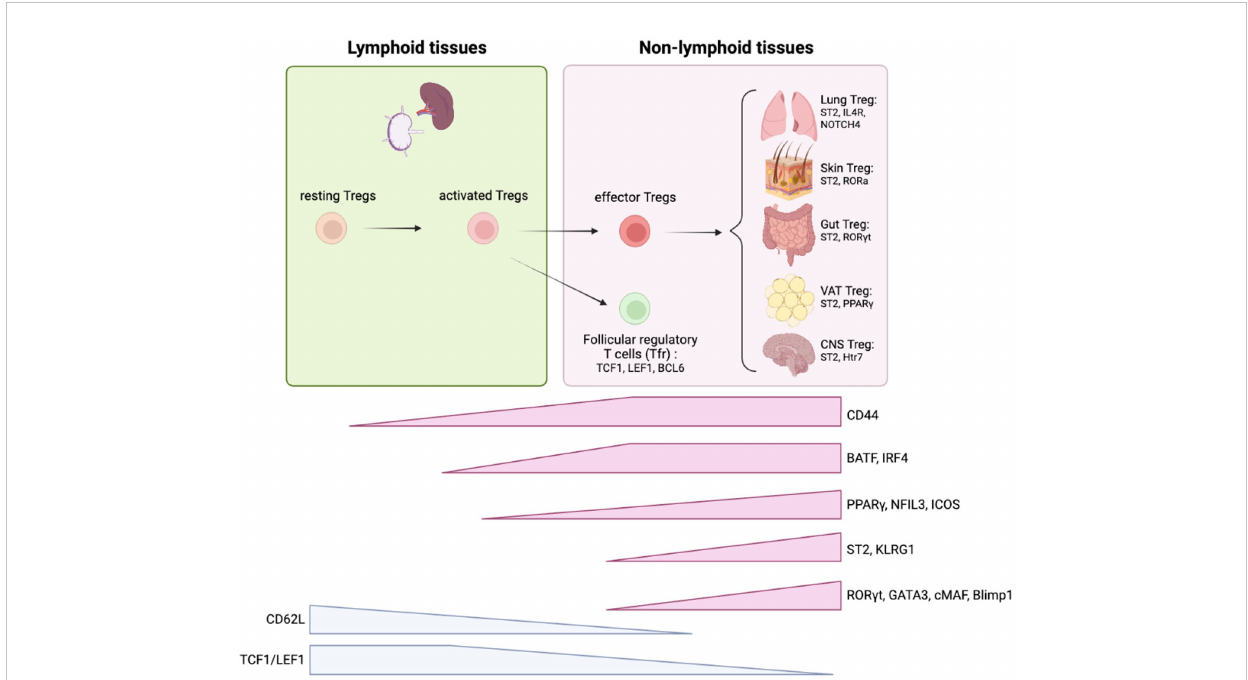
FIGURE 5 Treg ontogeny and key signature factors of tissue Tregs. Tregs are initially developed in thymus and migrate into secondary lymphoid organs. TCF1/ LEF1 are critical to maintain quiescent state of Tregs. Once resting Tregs are activated, the program initiated by BATF/IRF4 facilitates effector Treg differentiation. The stepwise induction of PPAR g and NFIL3 further proceed this program to achieve effector Treg signatures (i.e. ST2, KLRG1, ICOS). Effector Tregs migrate into non-lymphoid tissues and adopt to the microenvironment where they reside. ST2 expression is a general tissue Treg signature that is required for homeostatic maintenance of the tissue Treg pool through the IL-33/ST2 axis. Each tissue Tregs exhibit unique features. Lung Tregs express higher IL4R and Notch4; Skin Treg express higher ROR a ; Gut Treg express higher ROR g t, VAT Treg express higher PPAR g , and CNS Treg express higher Htr7. These features are mostly based on mice